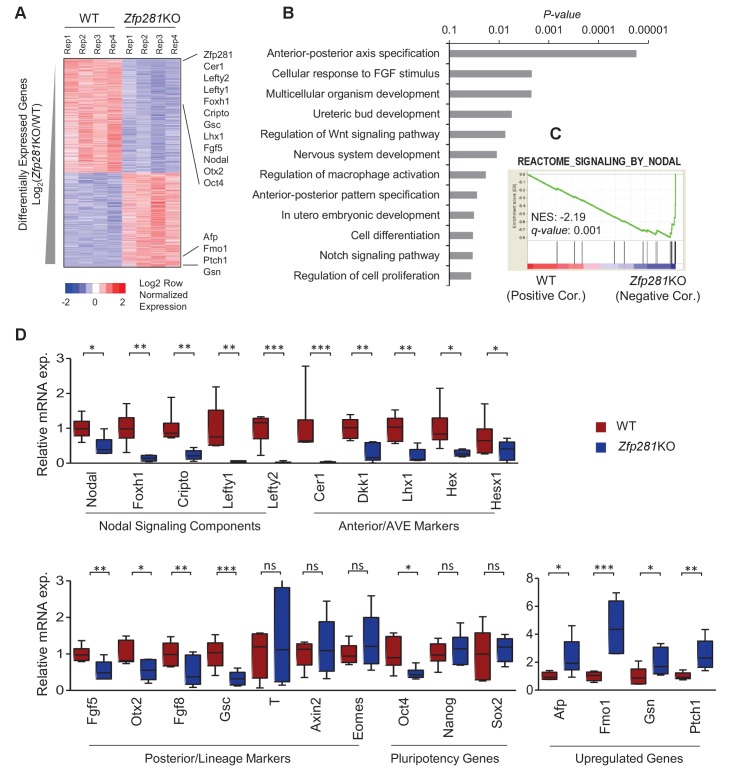
Zfp281KO embryos exhibit defects in Nodal signaling and expression of genes associated with anterior-posterior patterning.(A) Heatmap of genes differentially regulated between WT and Zfp281KO embryos (E6.5). (B) Gene ontology (GO) analysis for significant downregulated genes (fold-change <4, p-value<0.05) in Zfp281KO embryos. (C) Gene set enrichment analysis (GSEA) shows Nodal signaling as top pathway in downregulated genes in Zfp281KO embryos. (D) RT-qPCR for expression of genes at E6.5. For each genotype, n = 6 embryos. mRNA levels of WT embryos were normalized to 1. Student T-test was used examine statistical significance: ns = non significant, *p<0.05, **p<0.01, ***p<0.001. RT-qPCR primer sequences are provided in Figure 2—source data 2.10.7554/eLife.33333.009Figure 2—source data 1.RPKM values of significantly up- and down-regulated genes in WT and Zpf281KO embryos RNA-seq data.10.7554/eLife.33333.010Figure 2—source data 2.RT-qPCR primer sequences.